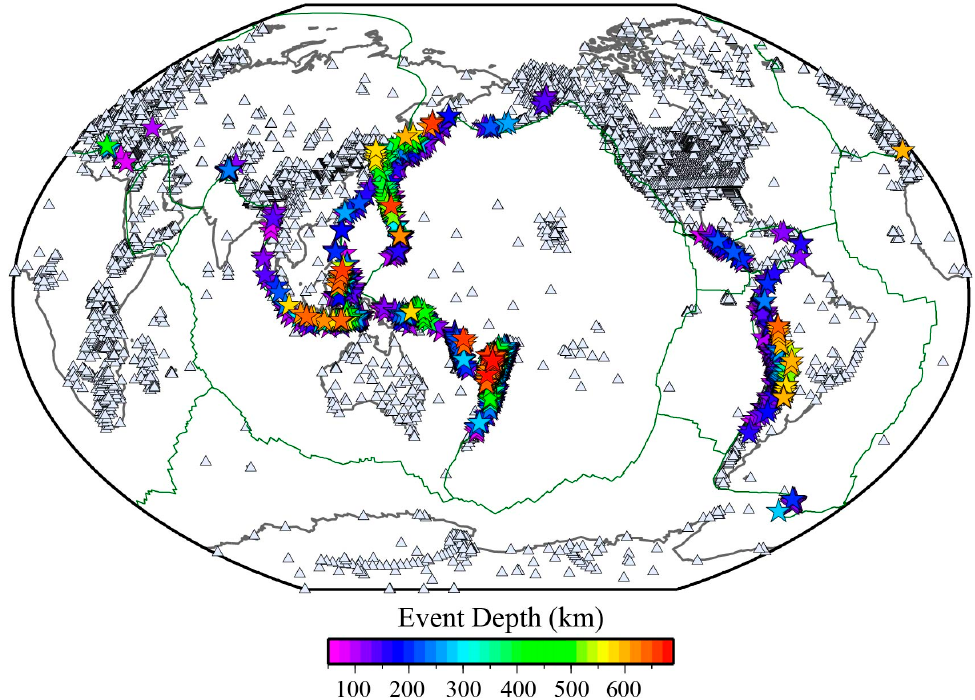
Figure 4. Events and stations used in this study. Events used in this study are shaded by earthquake depth. In total data from 1146 events with depths ≥ 75 km were used in this study. All unique broadband seismic stations for which we collected data and the data-passed quality control steps are shown with grey triangles. In total, data from 13,156 unique stations were used.